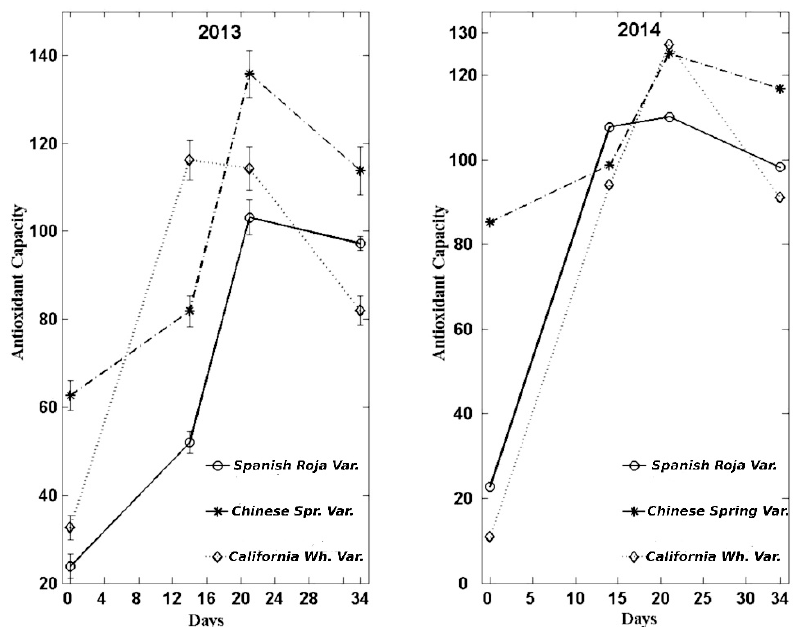
Figure 4. Evolution of antioxidant capacity (TROLOX mmol/kg lyophilized sample) during the manufacture of black garlic with three varieties and two types of garlic: one-year-old